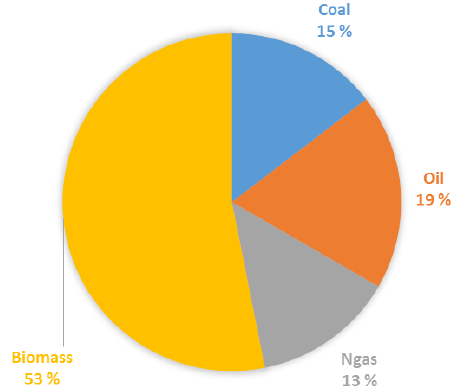
Figure 15. Industrial fuel consumption in Finland.